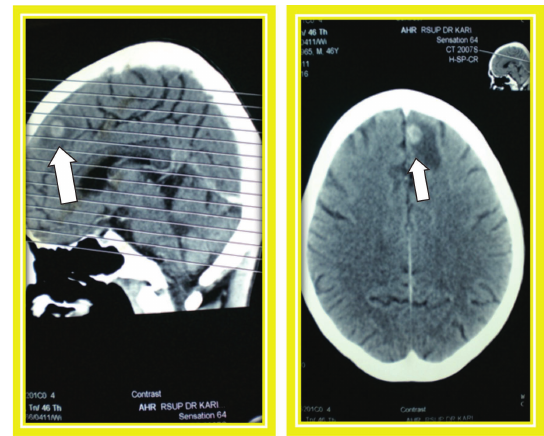
Mixed Lung Cancer in 46 Years Old, Male Smoker, Untreated Patient ...